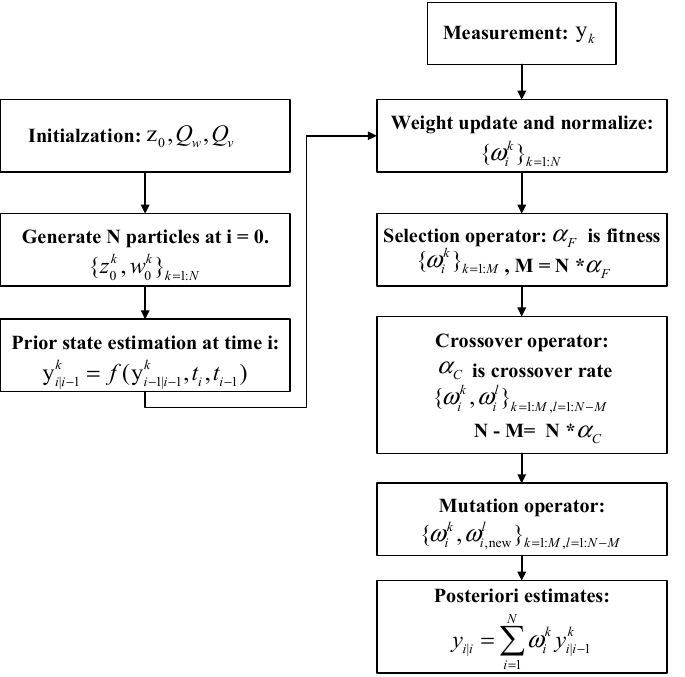
Figure 6. Flow chart of model correction method.